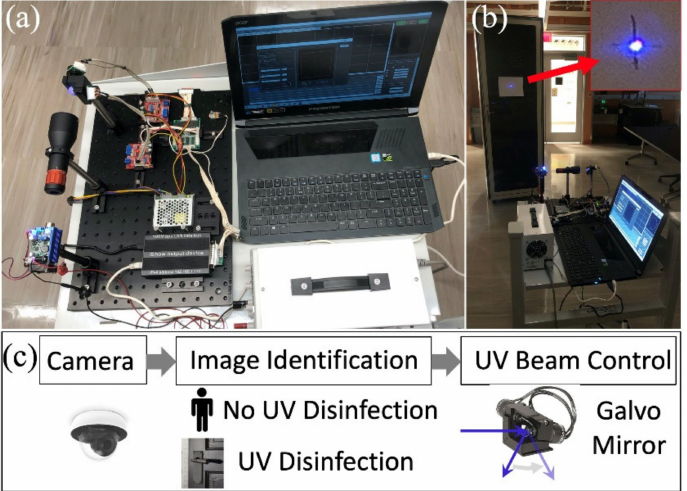
Figure 1. ( a ) Prototype on a moving cart; ( b ) system test with UV laser on; ( c ) system flowchart.